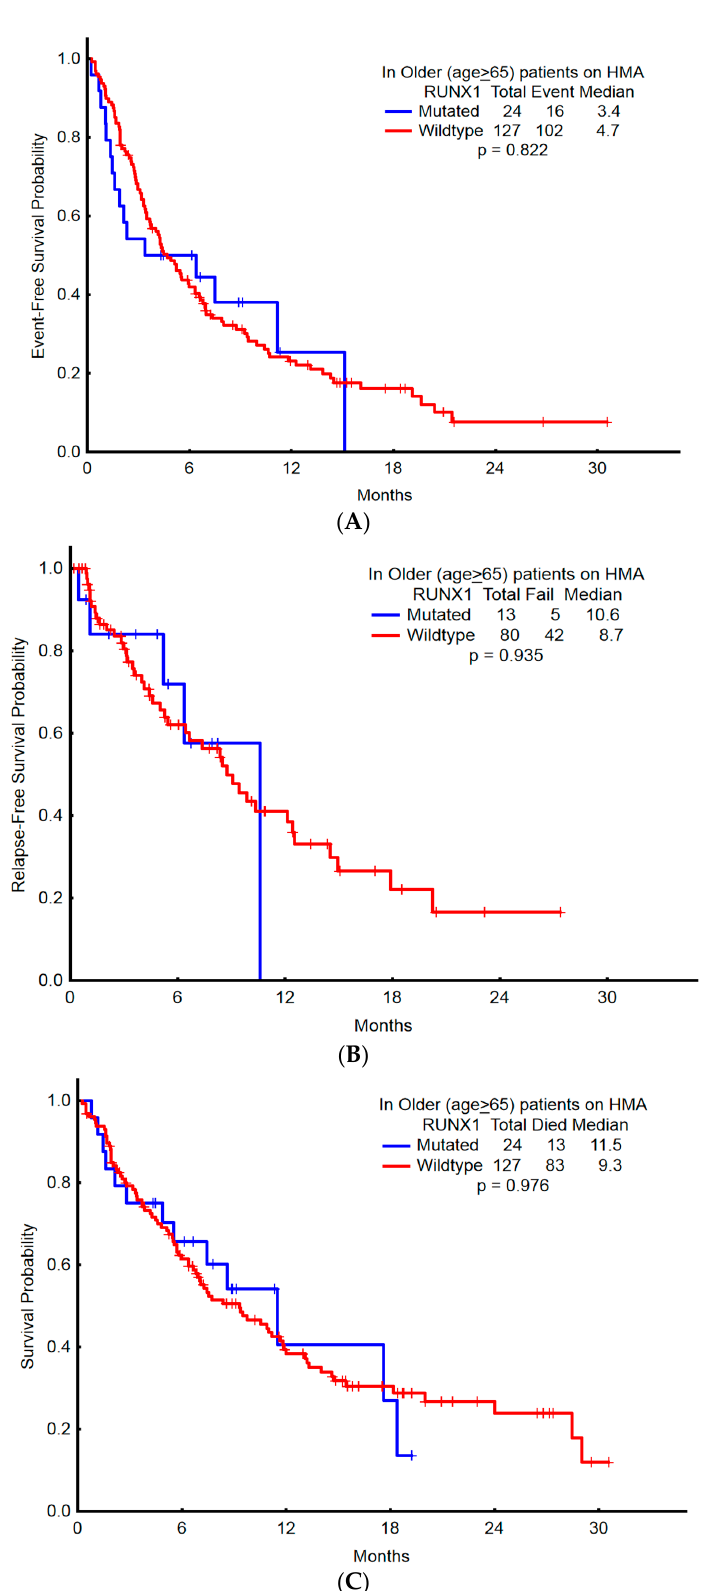
Figure 3. Survival probabilities among patients older than 65 years who received induction with hypomethylating agents, compared with the presence or absence of RUNX1 mutation. ( A ) Overall survival; ( B ) Relapse-free survival; ( C ) Event-free survival.